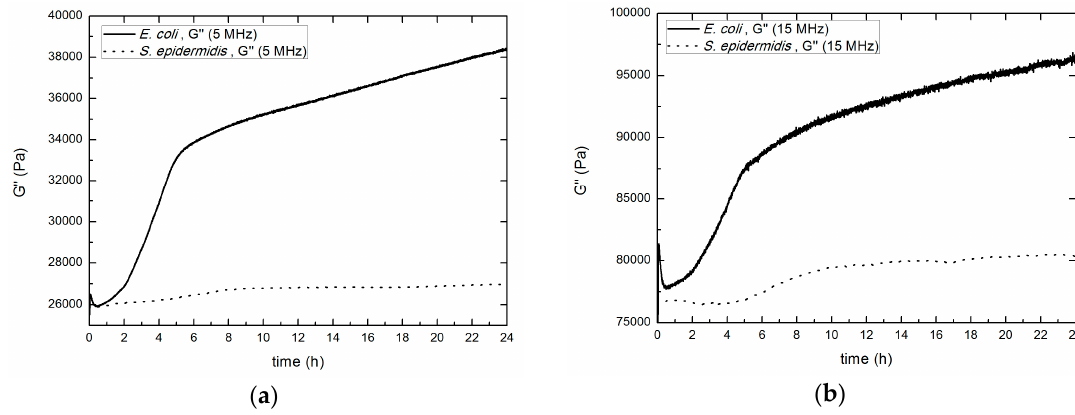
Figure 11. Evolution of the imaginary shear modulus for 5 MHz ( a ) and 15 MHz ( b ). Biofilm formed by S. epidermidis and E. coli are represented by dot line and solid line, respectively.